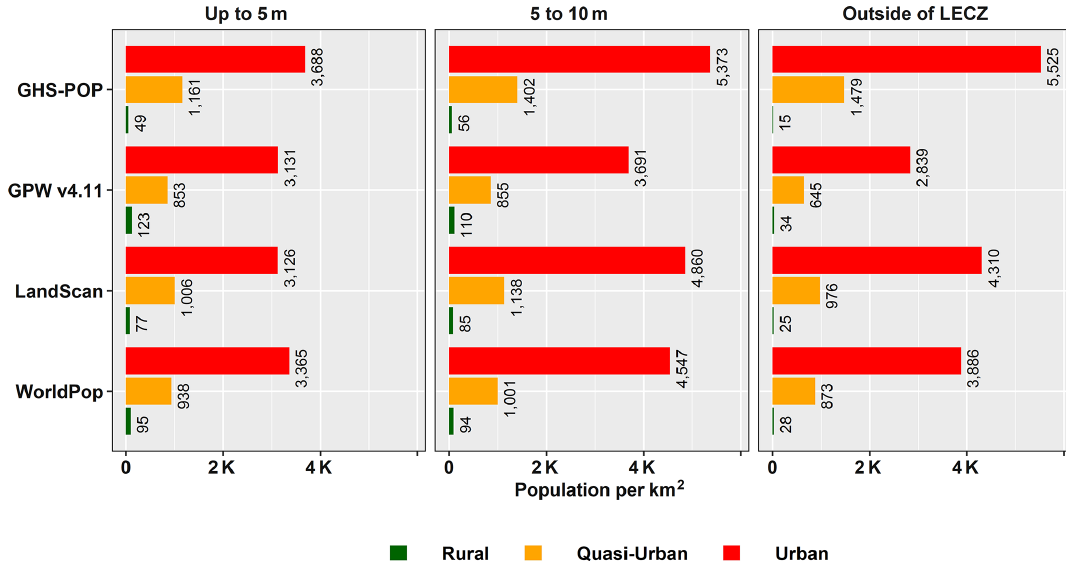
Figure 17. Population density of urban, quasi-urban and rural areas using GHS-SMOD, by LECZ (using MERIT DEM), according to different population data sets, 2015.